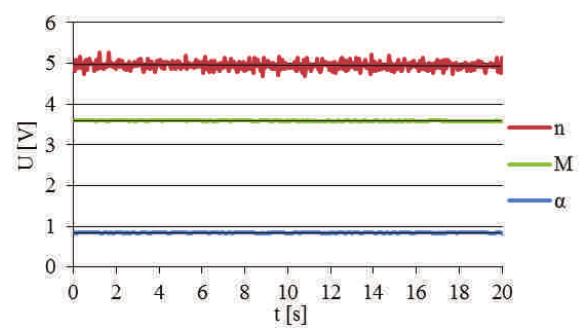
Fig. 1. A single measurement in static